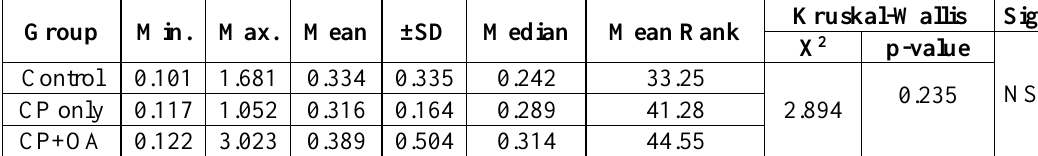
Table 4: Illustrates the analytic test for hsCRP.